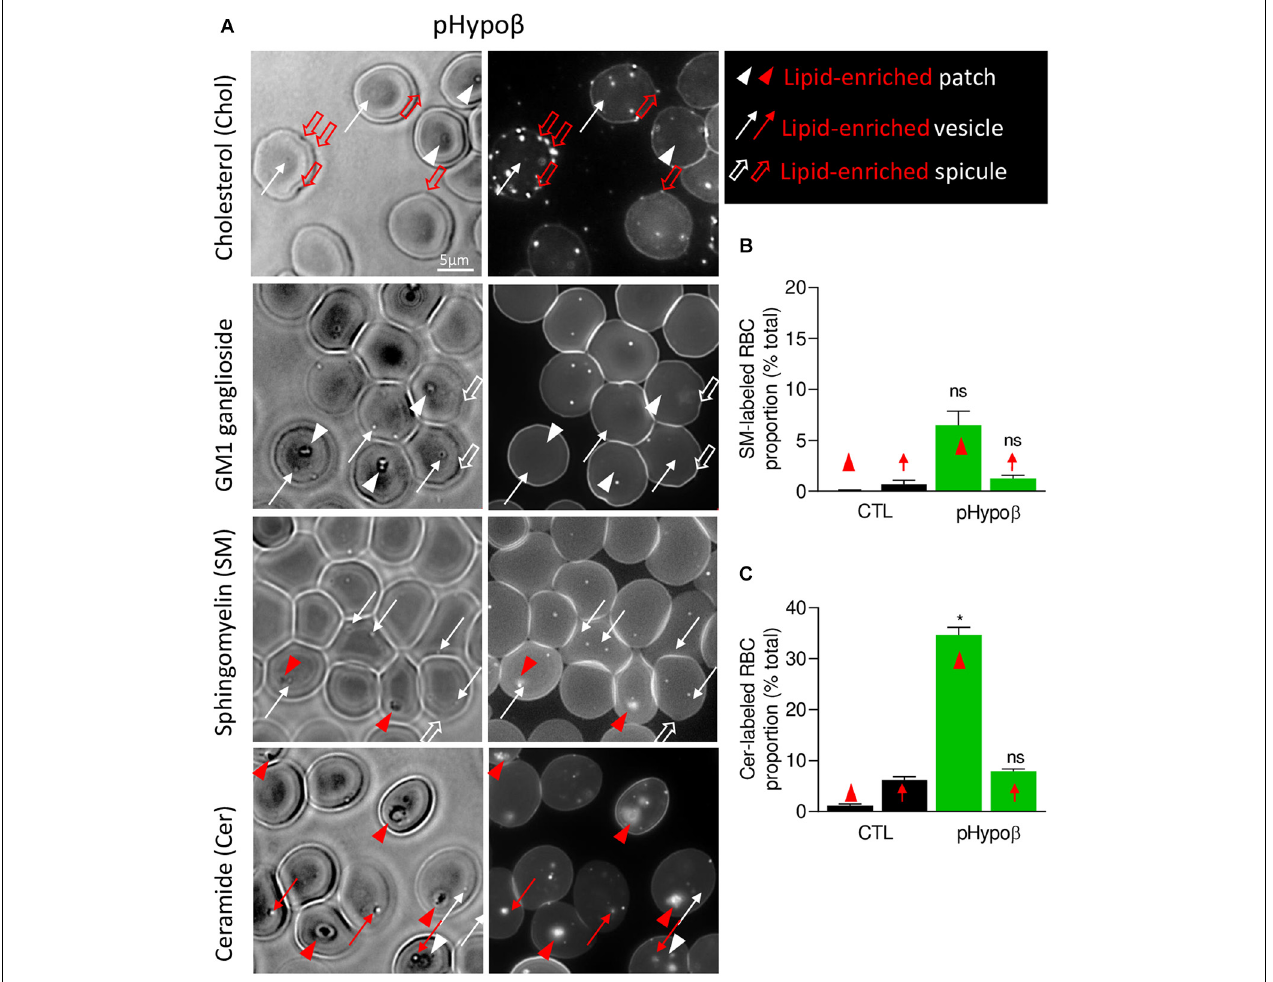
FIGURE 9 | The spicules at the pHypo β surface are mainly enriched in cholesterol whereas the patches and vesicles are mainly enriched in ceramide. RBCs from healthy donors (black columns) or pHypo β (green columns) were either labeled with the fluorescent Theta toxin fragment specific to endogenous cholesterol and then immobilized on PLL-coated coverslips (Chol; A ) or immobilized on PLL-coated coverslips and then labeled with fluorescent BODIPY analogs of GM1 ganglioside (GM1; A ), sphingomyelin (SM; A,B ); or ceramide (Cer; A,C ). All coverslips were then directly observed by vital fluorescence microscopy. (A) Representative images of pHypo β RBCs. Left, transmission microscopy image; right, fluorescence microscopy image. Lipid-enriched (red) or non-enriched (white) patches (arrowheads), vesicles (arrows), spicules (large open arrows) detected on the RBC surface on transmission images. (B,C) Quantification of the proportion of RBCs presenting SM- (B) or cer- (C) enriched patches or vesicles. Data are expressed as means ± SEM of 3–6 independent experiments. Mann–Whitney tests to compare enriched structures at the surface of healthy vs. pHypo β RBCs; ns, not significant; * p < 0.05.